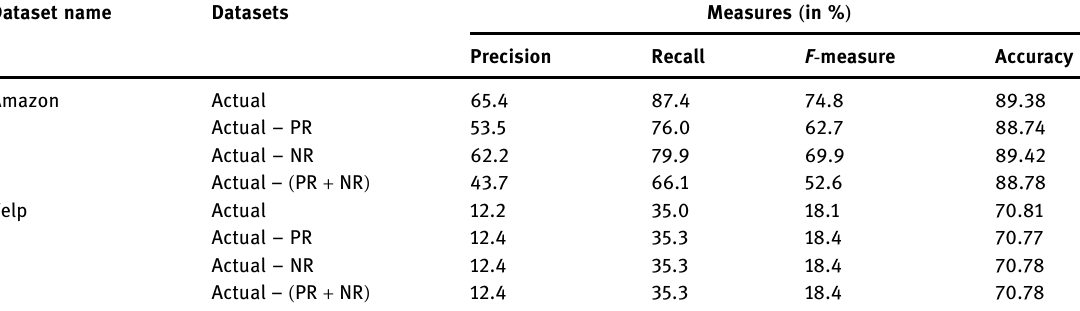
Table 4: Train Dataset: 80% Dataset